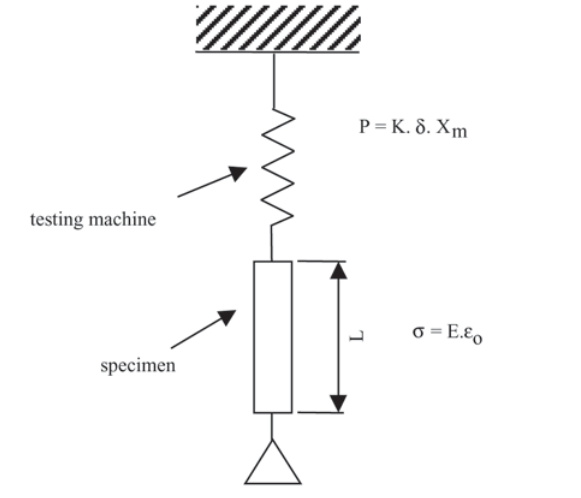
Figure 3. Representation of the testing system equipment/speci- men in the elastic regime. K = testing machine spring constant, δ .X = displacement due to testing machine m